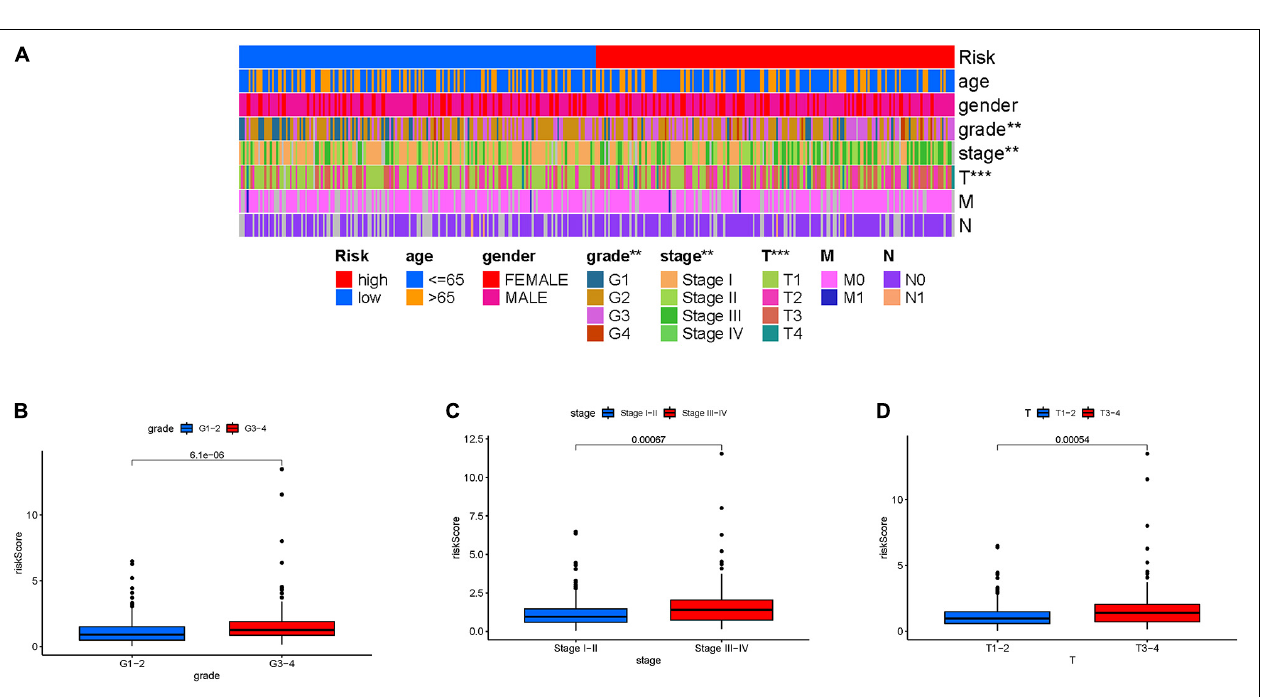
Frontiers in Genetics |